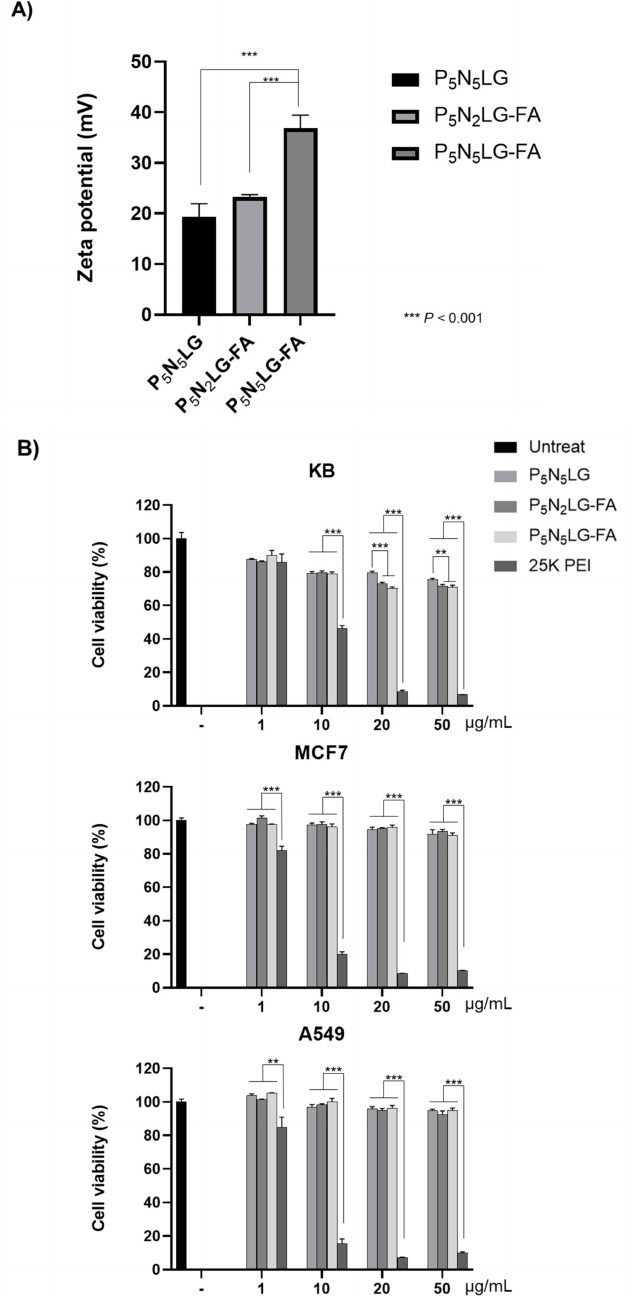
Figure 2. Physiochemical and cytotoxicity profile of PNLG polymers. ( A ) Net surface charges of PNLG based polymers were determined by Zetasizer. ( B ) In vitro cytotoxicity of polymers. KB, MCF7, and A549 cells were treated with of P 5 N 5 LG, P 5 N 2 LG-FA, P 5 N 5 LG-FA (1 to 50 µ g/mL), along with 25 kDa branched PEI as positive control and PBS as negative control for 48 h. The cell viability was determined by MTT assay. Each cell line was tested at least three times and data shown are representative experiments performed in triplicate. Bars represent mean ± SD. ** p < 0.01, *** p <